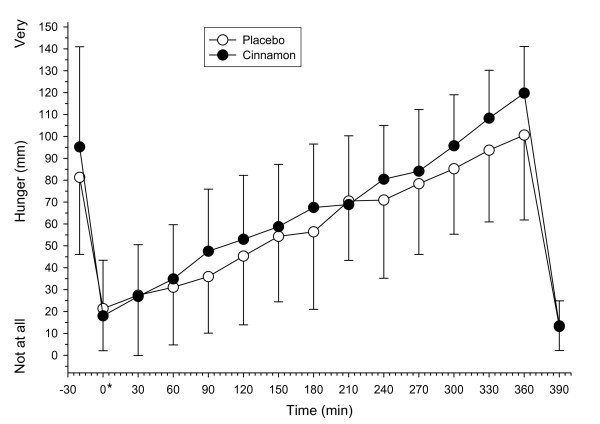
Visual analogue scale (VAS) scores for sensations of hunger in healthy subjects before and after the ingestion of a high-fat test meal supplemented with 3 g cinnamon or placebo (n = 8). * Represents the time immediately after breakfast. Values are means, with SD represented by vertical bars.